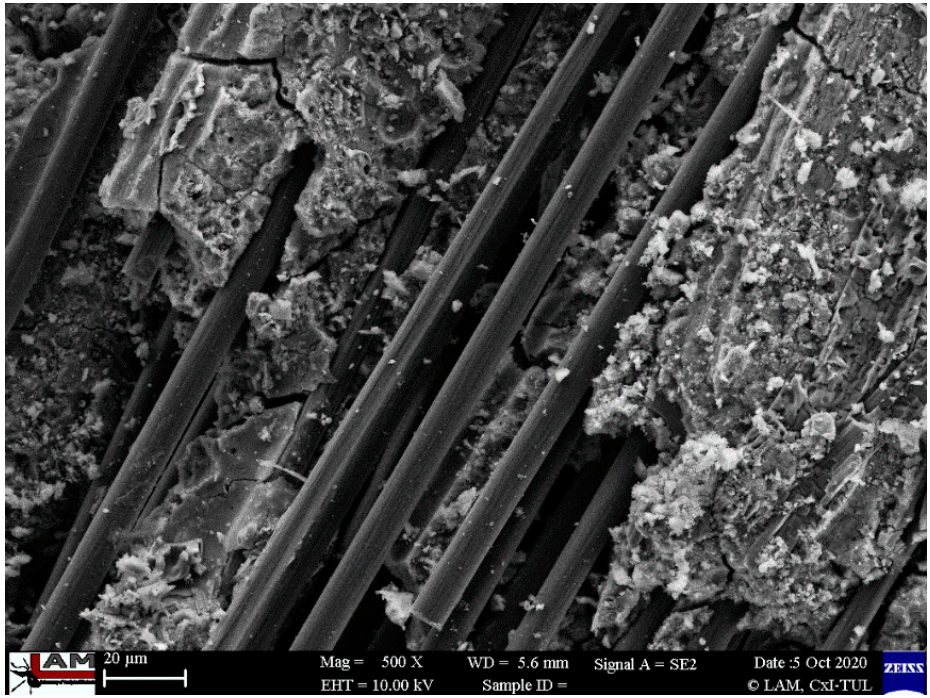
Figure 10. Microstructure of the cast samples reinforced with carbon fiber with visible fibers agglomerations.